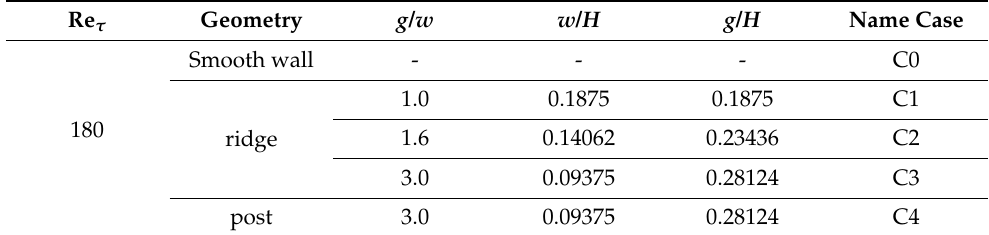
Figure 4. The dimensionless length and structured mesh of the channel flow in the simulation. Table 2. Information related to the computational domain, number of grids, and resolution with different ratios between the g (gap) and w (width) of the superhydrophobic